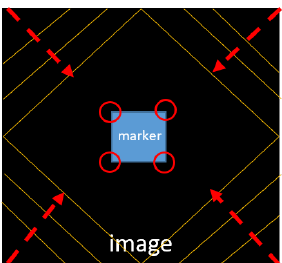
Figure 1. Flowchart of image-based positioning